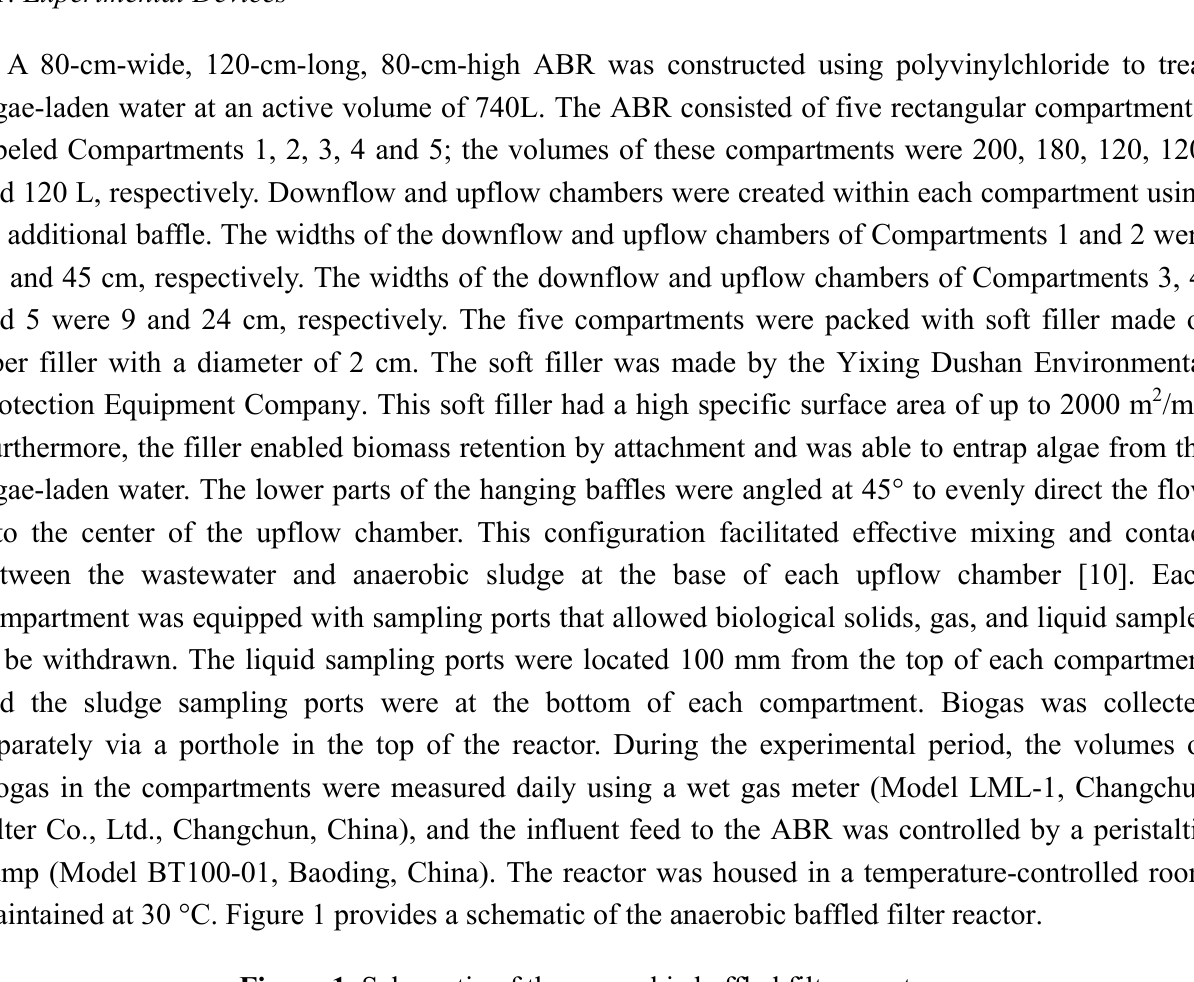
Figure 1. Schematic of the anaerobic baffled filter